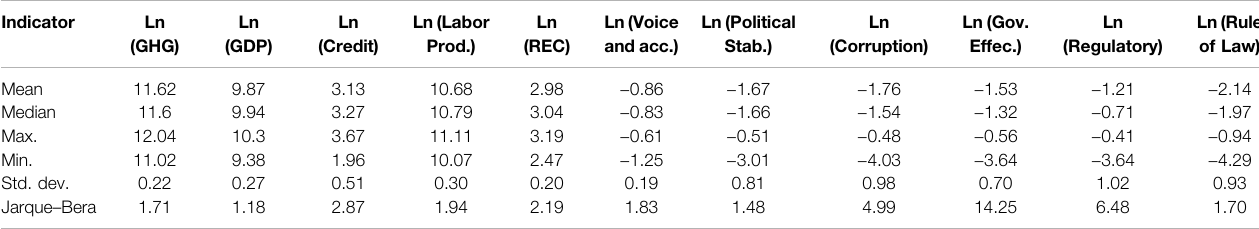
TABLE 1 | Descriptive statistics.